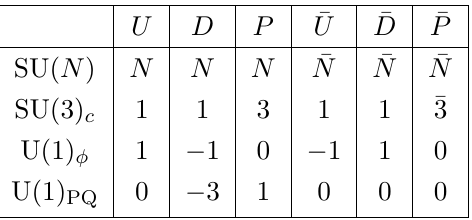
Table 2 . The matter content of a model of the NGAD baryogenesis with a PQ